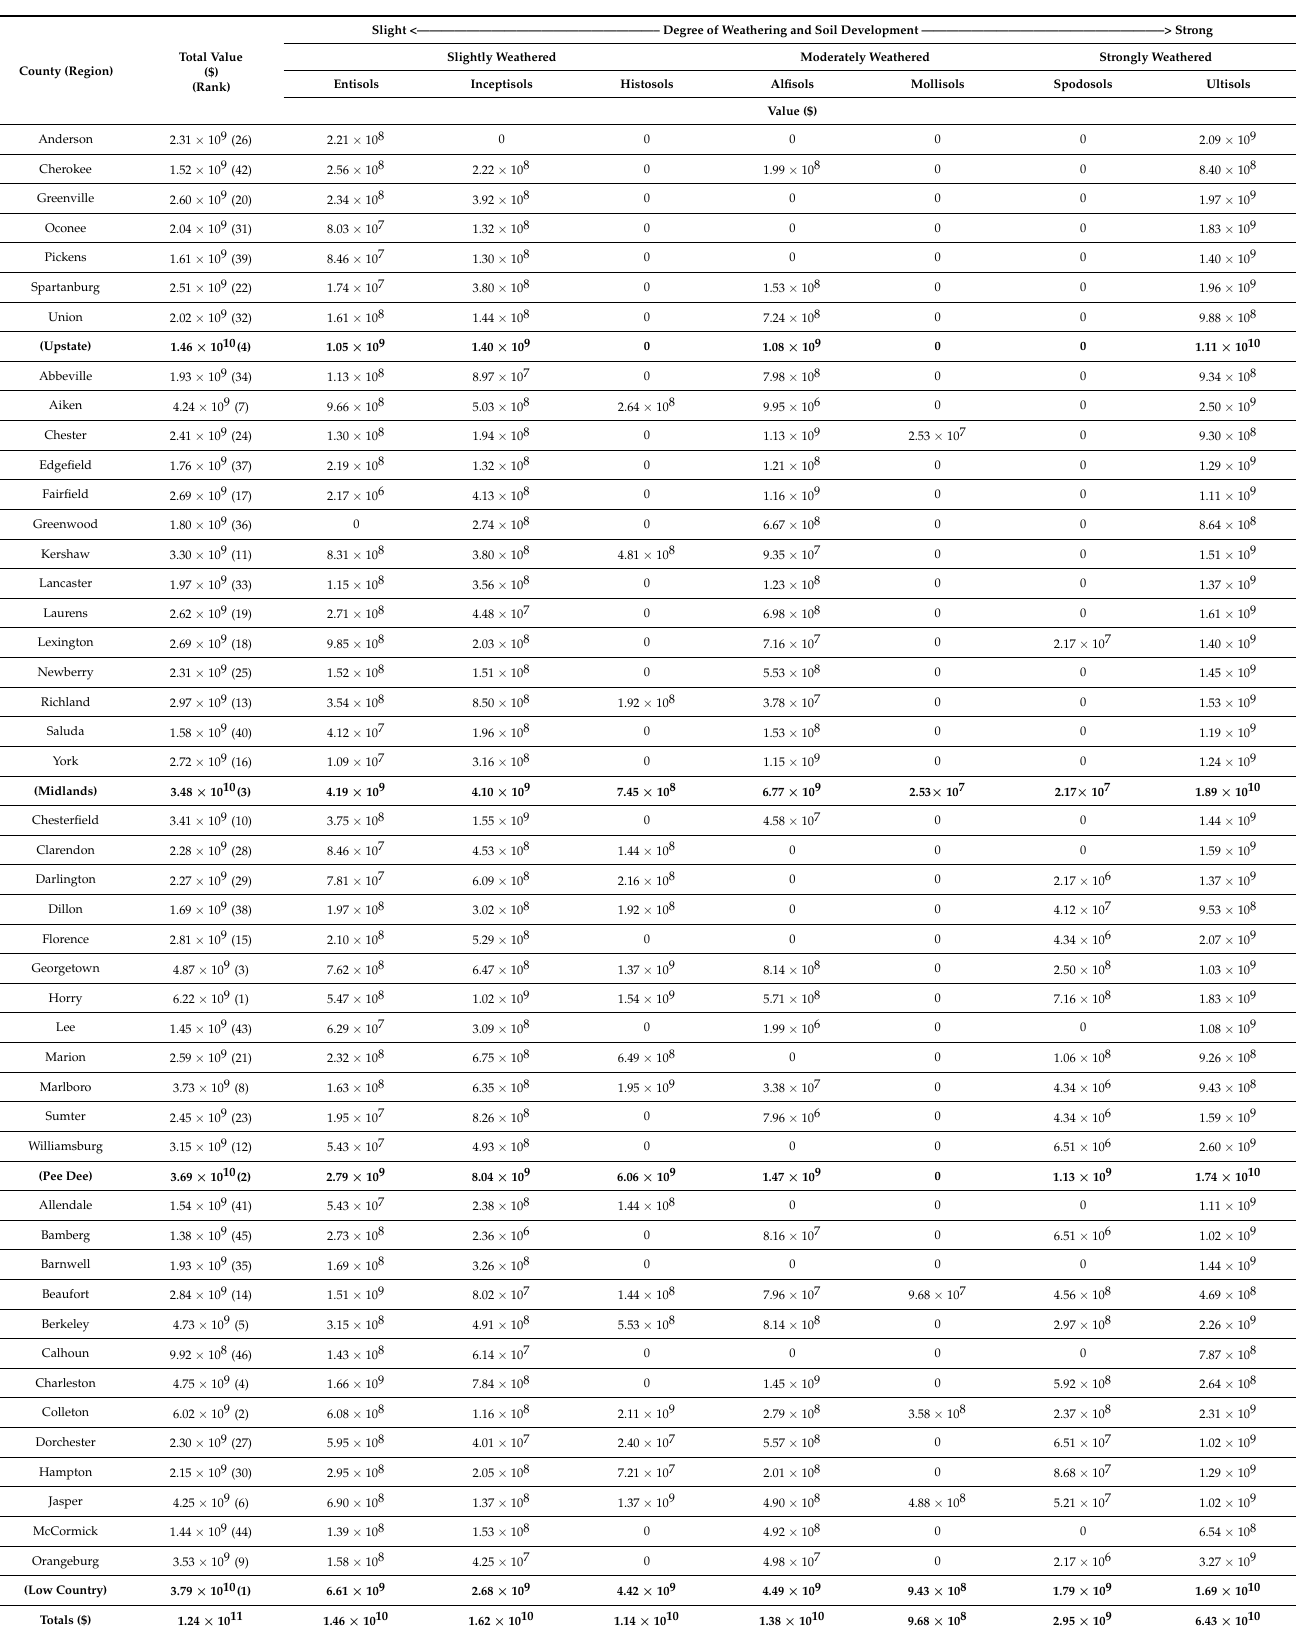
Table 10. Total soil carbon (TSC) values by county, region, and soil order for the state of South Carolina (U.S.A.), based on mid-point total soil carbon (TSC) numbers for the upper 2 m from Guo et al. 2006 [18] and a social cost of carbon (SC-CO 2 ) of $46 per metric ton of CO 2 (2007 U.S. dollars with an average discount rate of 3%